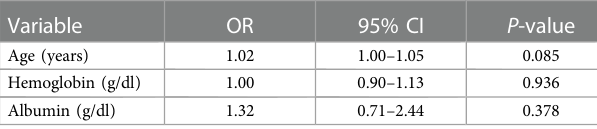
TABLE 4 Ordinal logistic analysis of predictors of Clavien-Dindo score in patients who underwent